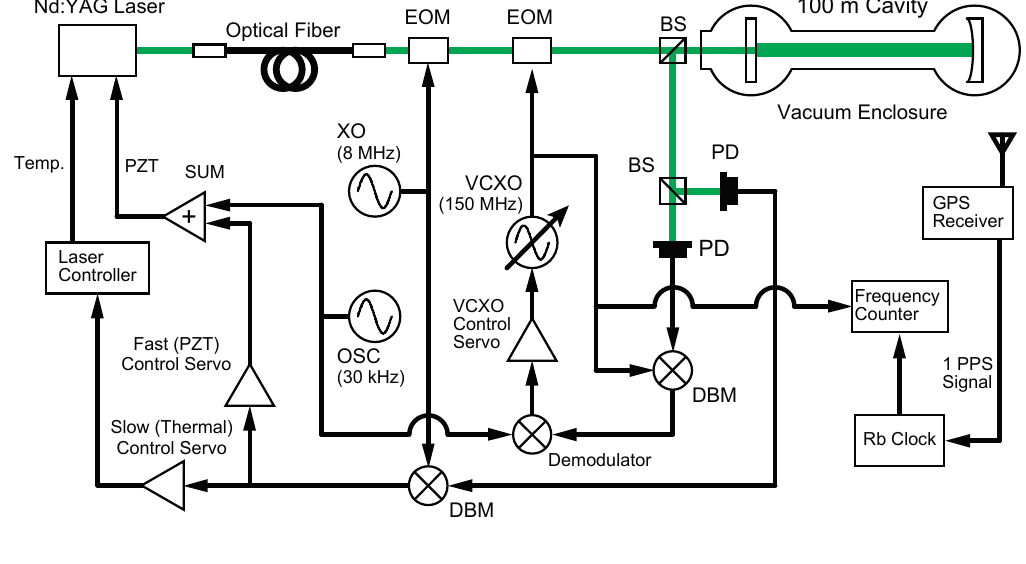
Figure 1. Block diagram of the absolute distance meter (ADM). EOM, electro-optic modulator; PZT, piezoelectric transducer; XO, quartz crystal oscillator; VCXO, voltage controlled crystal oscillator; PD, photo detector; DBM, double-balanced